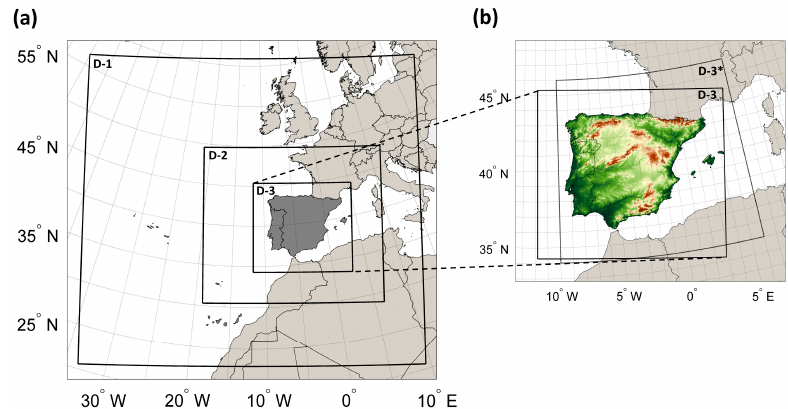
Figure 1. ( a ) Configuration of the domains used in the regional Weather Research and Forecasting (WRF) model implementation. The model ran in two-way nesting mode with increasing domain resolutions of 81 km (D-1), 27 km (D-2), and 9 km (D-3); ( b ) topography of the study area (Iberian Peninsula); WRF domain D-3 (9 km resolution) and domain D-3* (0.2 ◦ resolution). In this study, we used domain